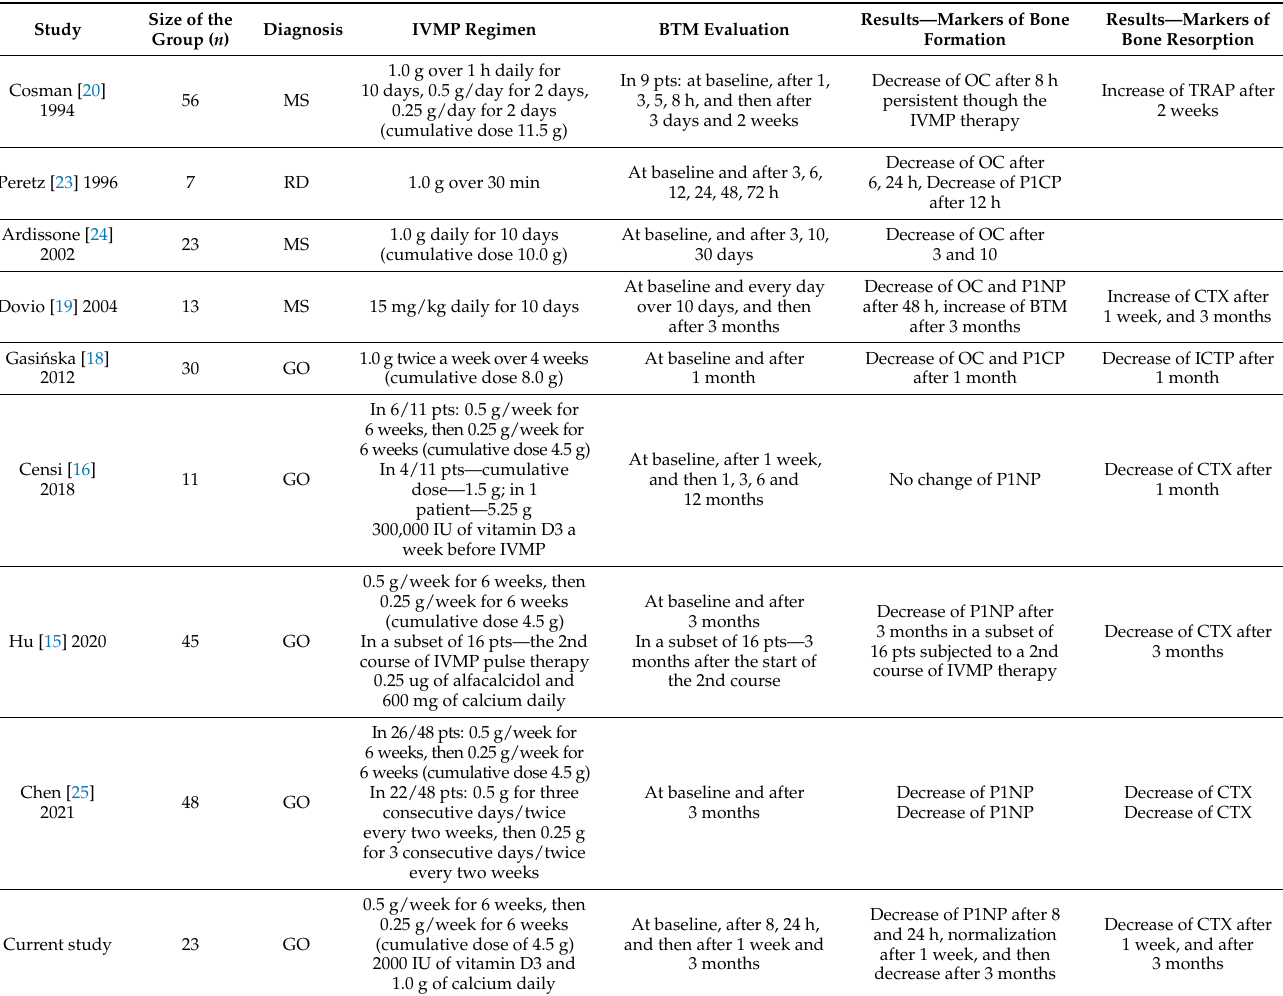
Table 3. Summary of studies that investigated acute changes in levels of serum bone markers in patients treated with